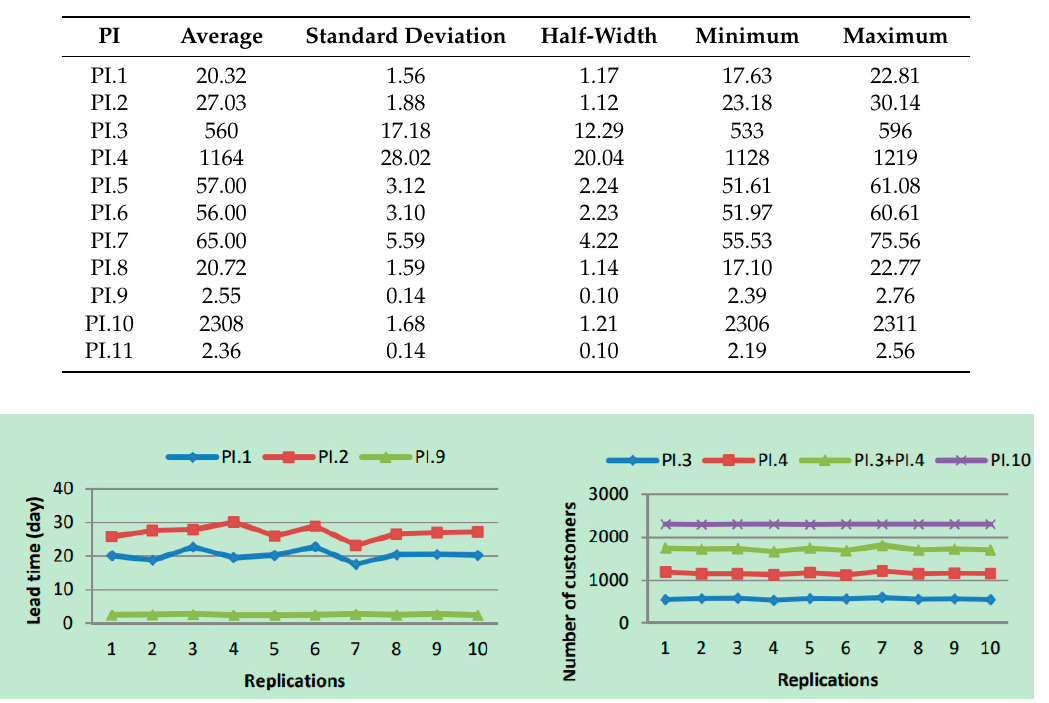
Table 4. Statistical results of each performance indicator.